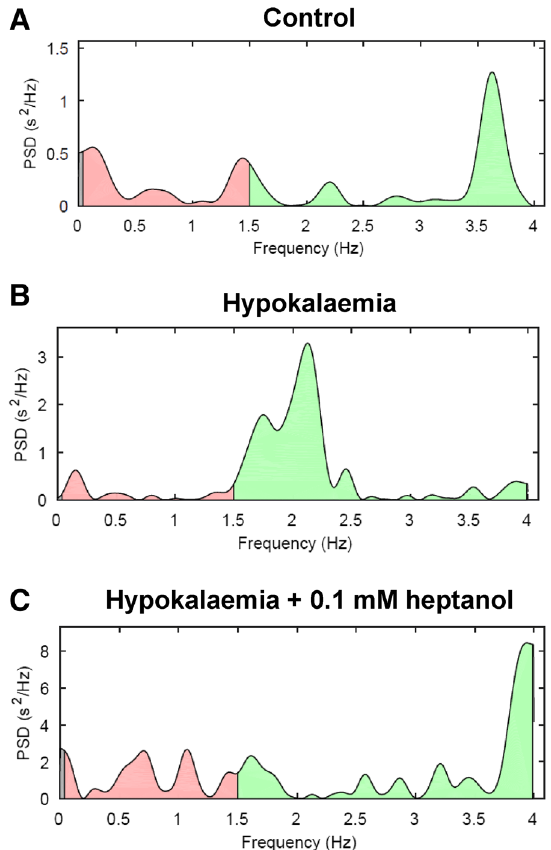
Fig. 3 Examples of frequency spectra using the Fast Fourier Transform method from a representative heart before ( A ) or after the application of experimental hypokalaemia ( B ) and hypokalaemia with 0.1 mM heptanol ( C